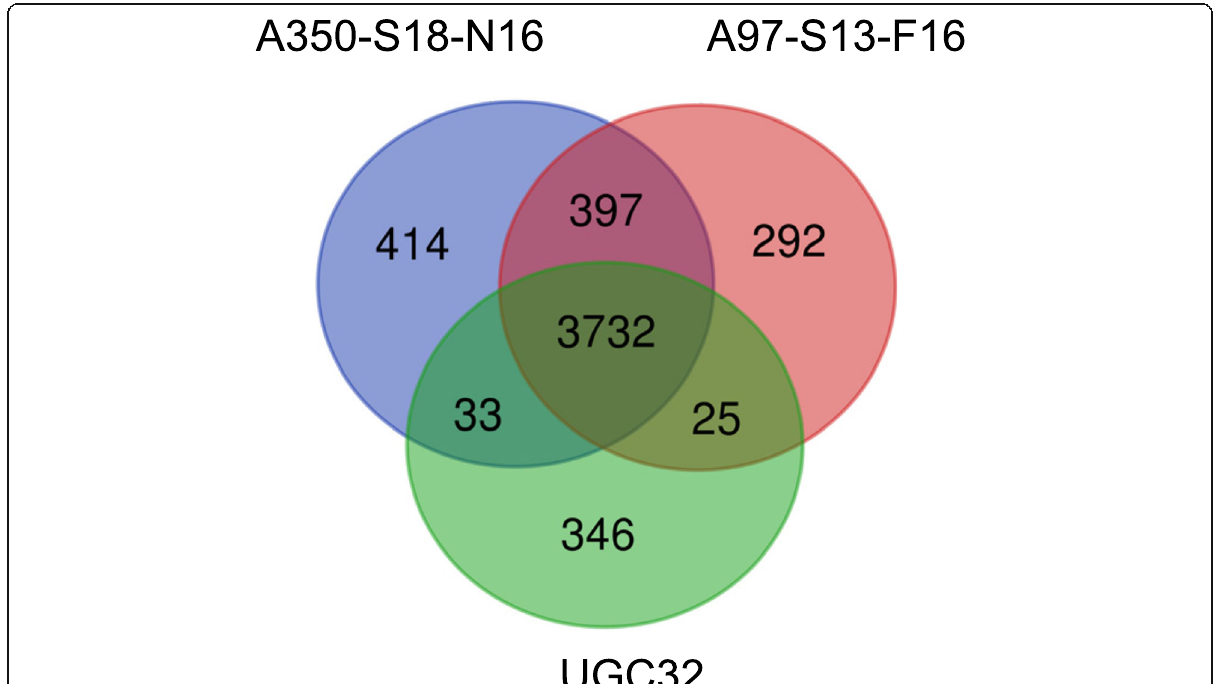
Fig. 3 Venn diagram. Shared and unique genes between the genomes of “ P. peruviense ” A97-S13-F16 and A350-S18-N16 and the proposed “ P. peruviense ” type strain UGC32. Orthology was assumed using a threshold of 80% identity on at least 80% of the protein